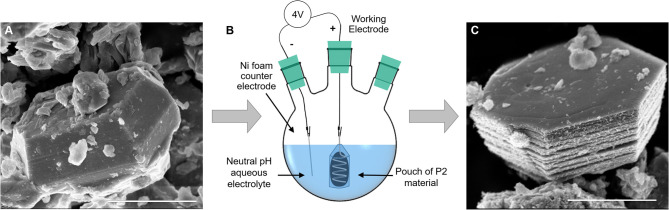
Effect of batch expansion on particle morphology: (A) a pristine P2 NaMCu particle has a compact structure, which expands after electrochemical water insertion. (B) A schematic of the electrochemical expansion setup, where the P2 material is contained in a dialysis tubing pouch around a coil of Pt wire, and the counter electrode is Ni foam. (C) A typical fully expanded NaMCu particle, which retains its ab-plane morphology but expands vertically due to water insertion. Scale bar 2 μm.